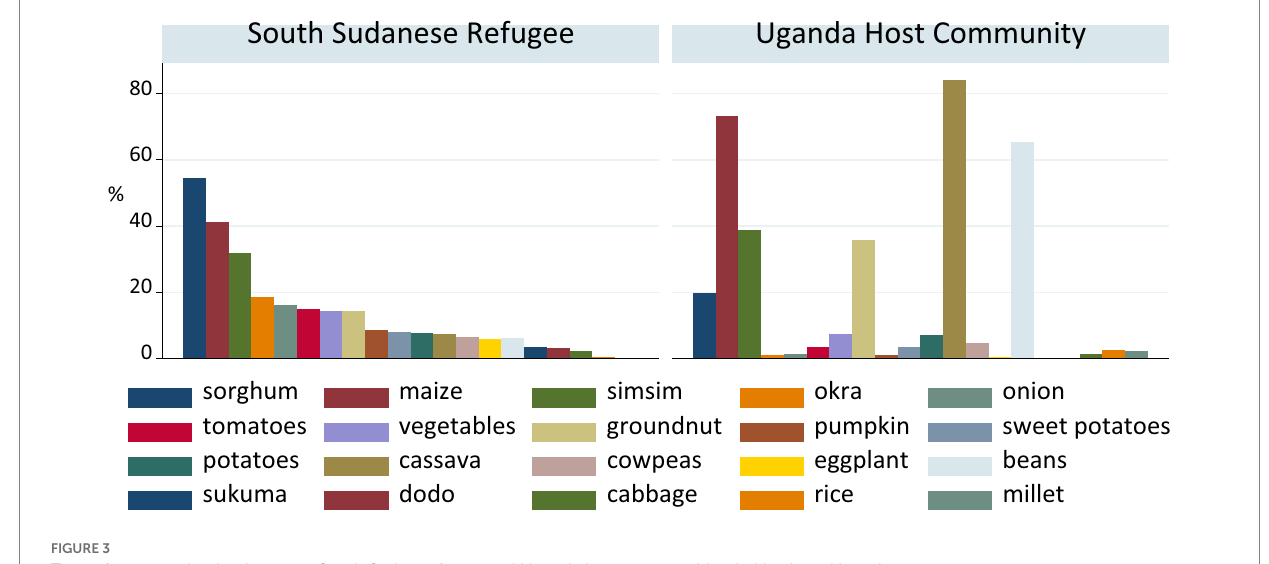
FIGURE 3 Type of crop production between South Sudan refugee and Uganda host communities, in Northern Uganda.